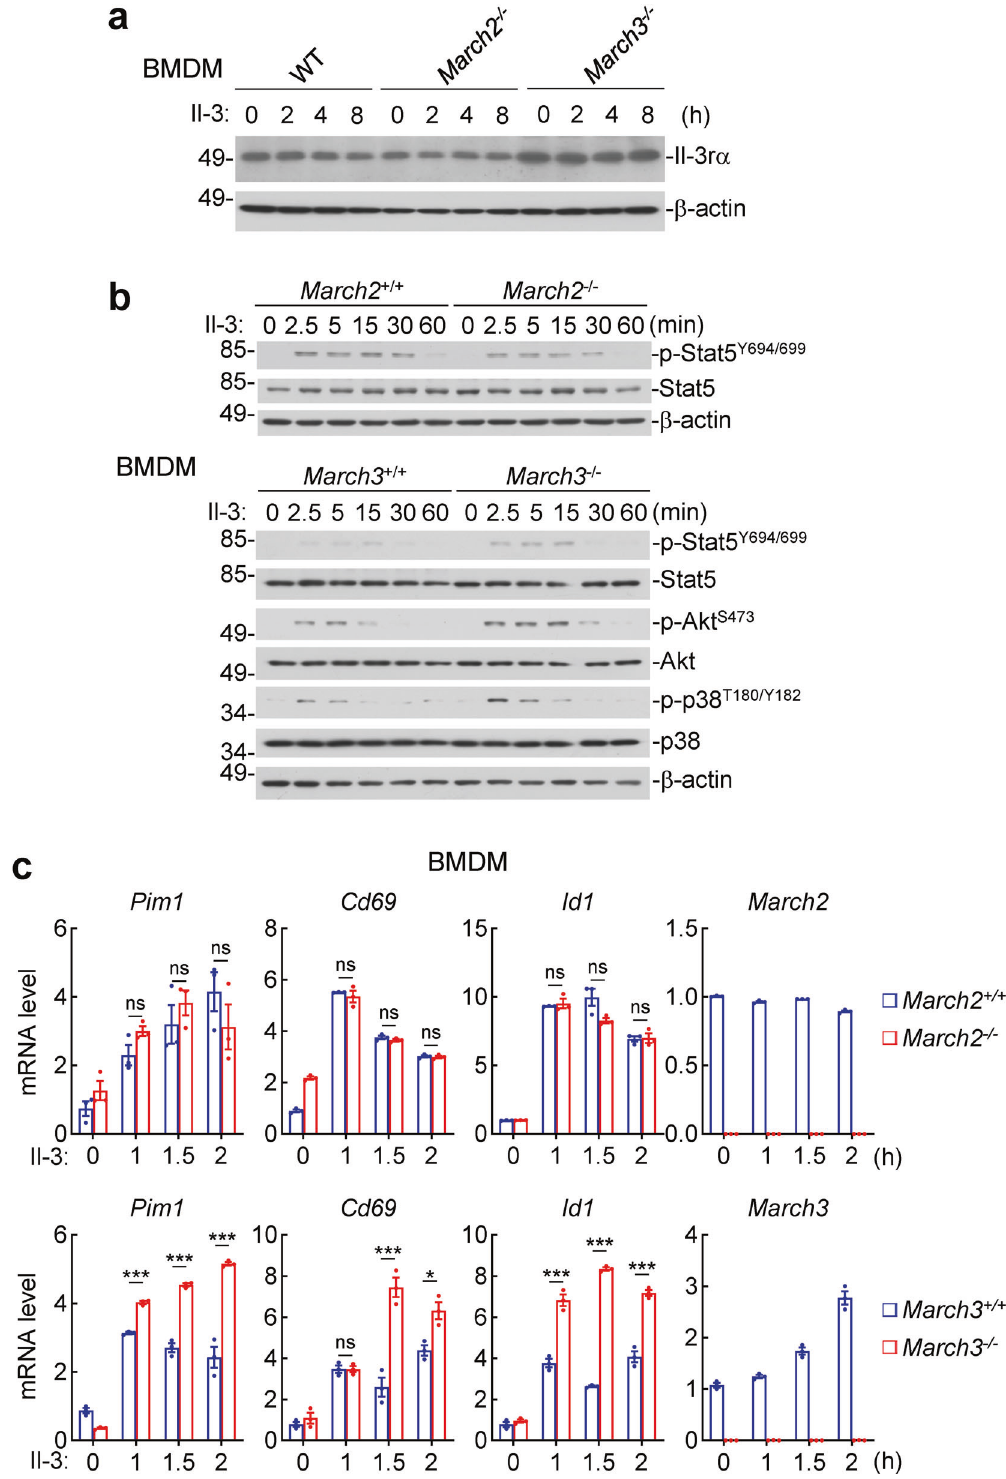
Fig. 2 March3-de fi ciency promotes Il-3-induced signaling in BMDMs. a Effects of March2, 3-de fi ciency on Il-3r α levels. Wild-type, March2 − / − and March3 − / − bone marrow-derived macrophages (BMDMs) (1 × 10 6 ) were left untreated or treated with Il-3 (50 ng/mL) for the indicated times before immunoblotting analysis for detection of Il-3r α and β -actin. b Effects of March2, 3-de fi ciency on Il-3-induced phosphorylation of signaling components. The indicated BMDMs (1 × 10 6 ) were left untreated or treated with Il-3 (25 ng/mL) for the indicated times before immunoblotting analysis for detection of the indicated proteins. c Effects of March2, 3-de fi ciency on Il-3-induced transcription of downstream genes. Wild-type, March2 − / − or March3 − / − BMDMs (1 × 10 6 ) were left untreated or treated with Il-3 (25 ng/mL) for the indicated times before qPCR analysis. Data shown are means ± SEM from one representative experiment performed in triplicate. * P < 0.05, *** P < 0.001; ns, not signi fi cant. All the experiments were repeated for at least two times with similar results